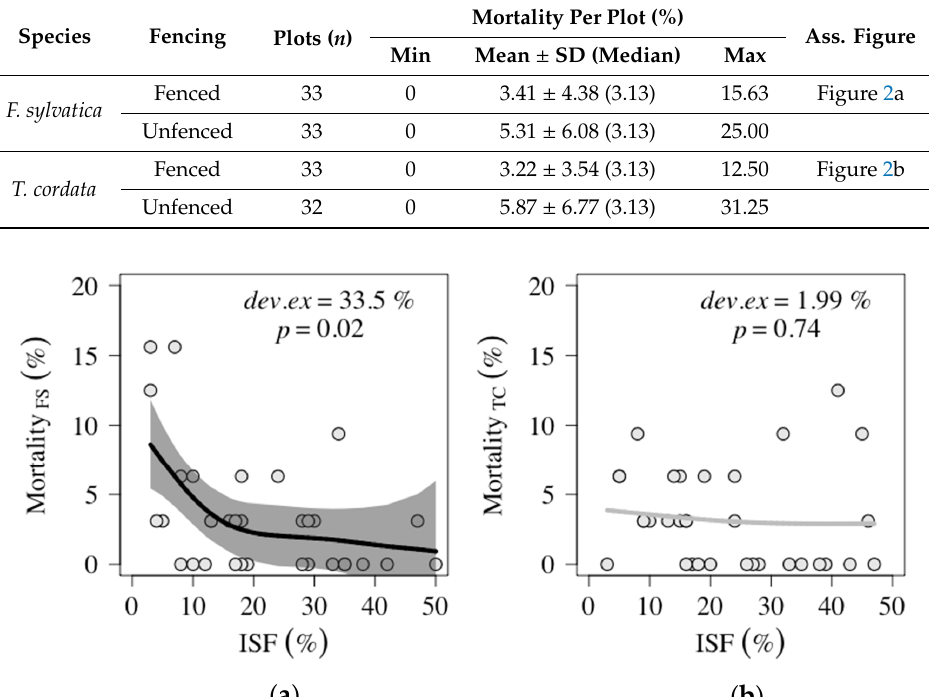
Figure 2. Mortality of ( a ) F. sylvatica seedlings (FS) and ( b ) T. cordata seedlings (TC) on fenced plots ( n = 33) in association with light, measured as indirect site factor (ISF). Significant trends ( p < 0.05) in association with light are shown as a black line, non-significant trends as a grey line. Shaded grey area shows the 95% confidence interval. Both explained deviance and p -values were extracted from the generalized additive model (GAM)-models.